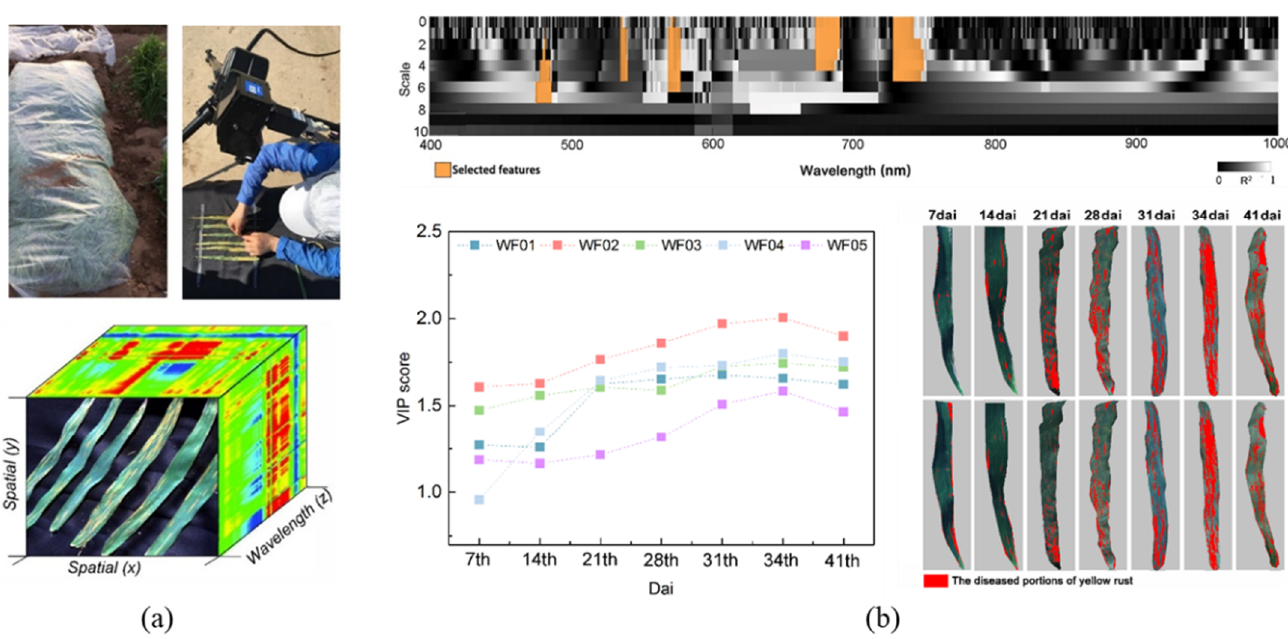
Figure 4. Acquisition of hyperspectral images of leaves ( a ) and the method and result of wheat yellow rust identification ( b ).